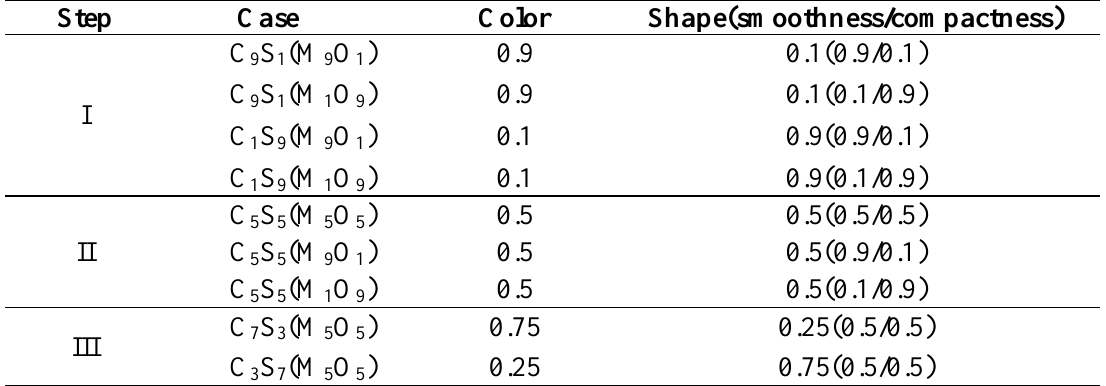
Table 2. Different weights for finding optimal segment size. The notation conveys information about the weights for color, shape, smoothness or compactness (C = color, S = shape, M = smoothness, O = compactness, subscript 1 = 0.1, 3 = 0.25, 5 = 0.5, 7 = 0.75 and 9 =